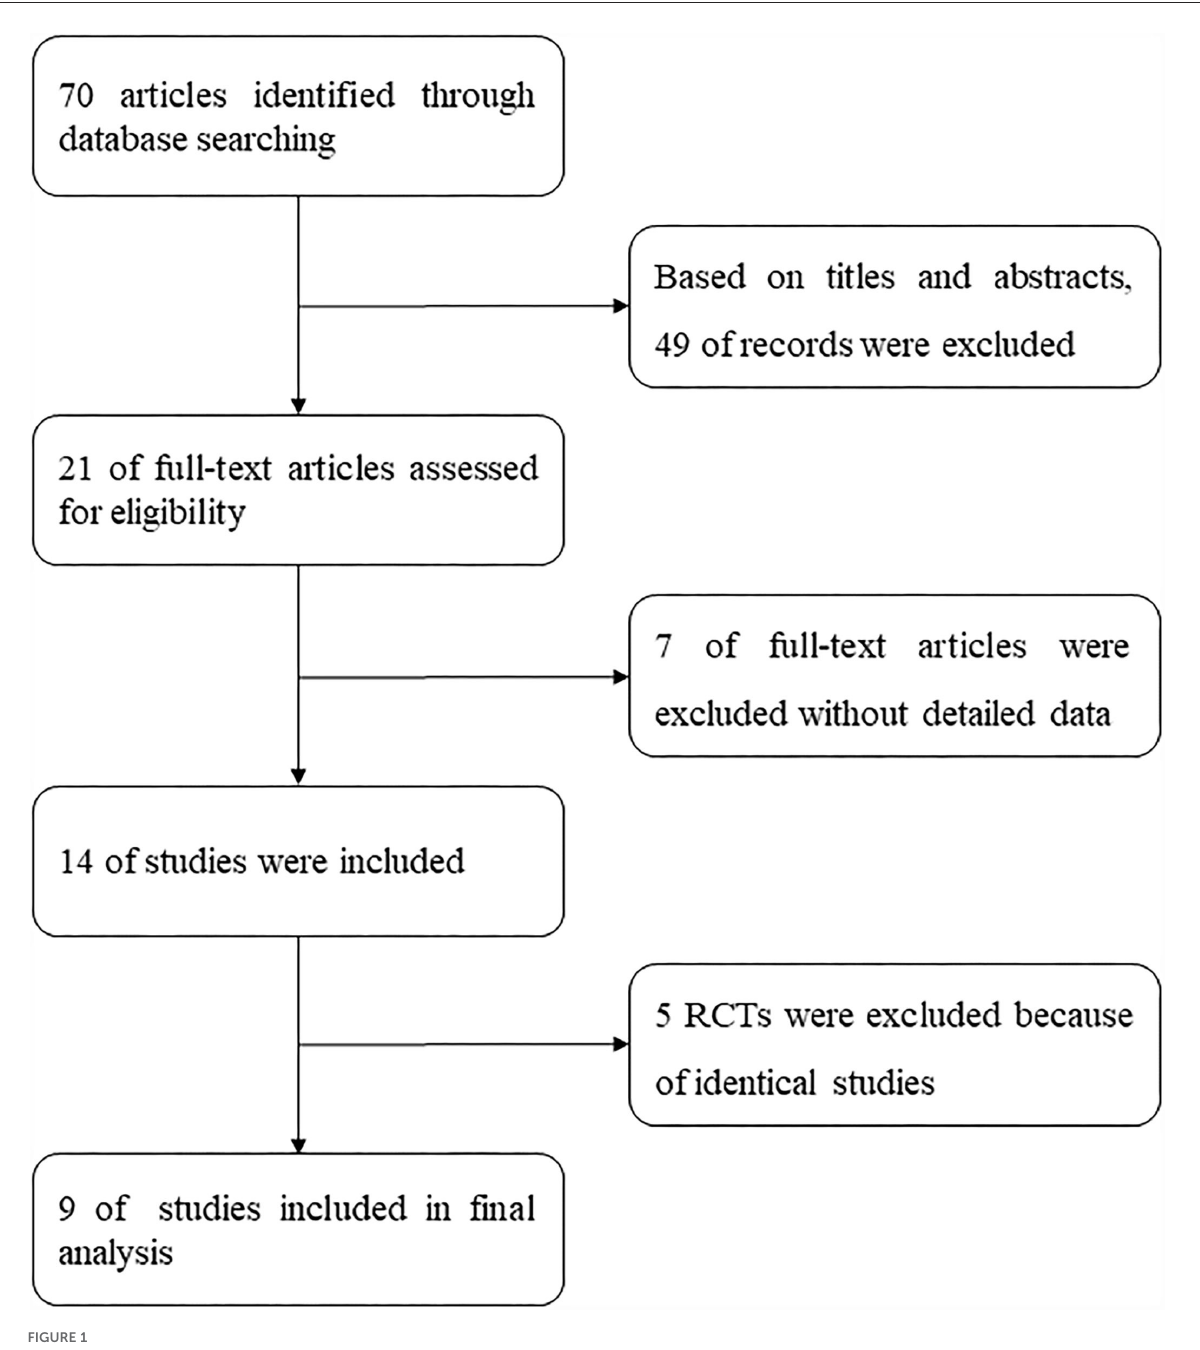
FIGURE1 Flowchart of selection PRISMA. RCTs, randomized controlled